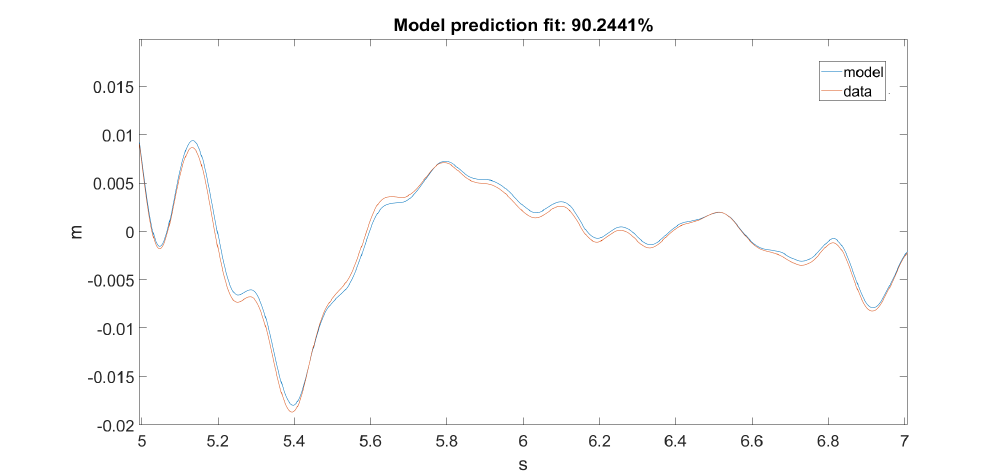
Figure 13. Prediction for Ground Motion 1, zoomed in.